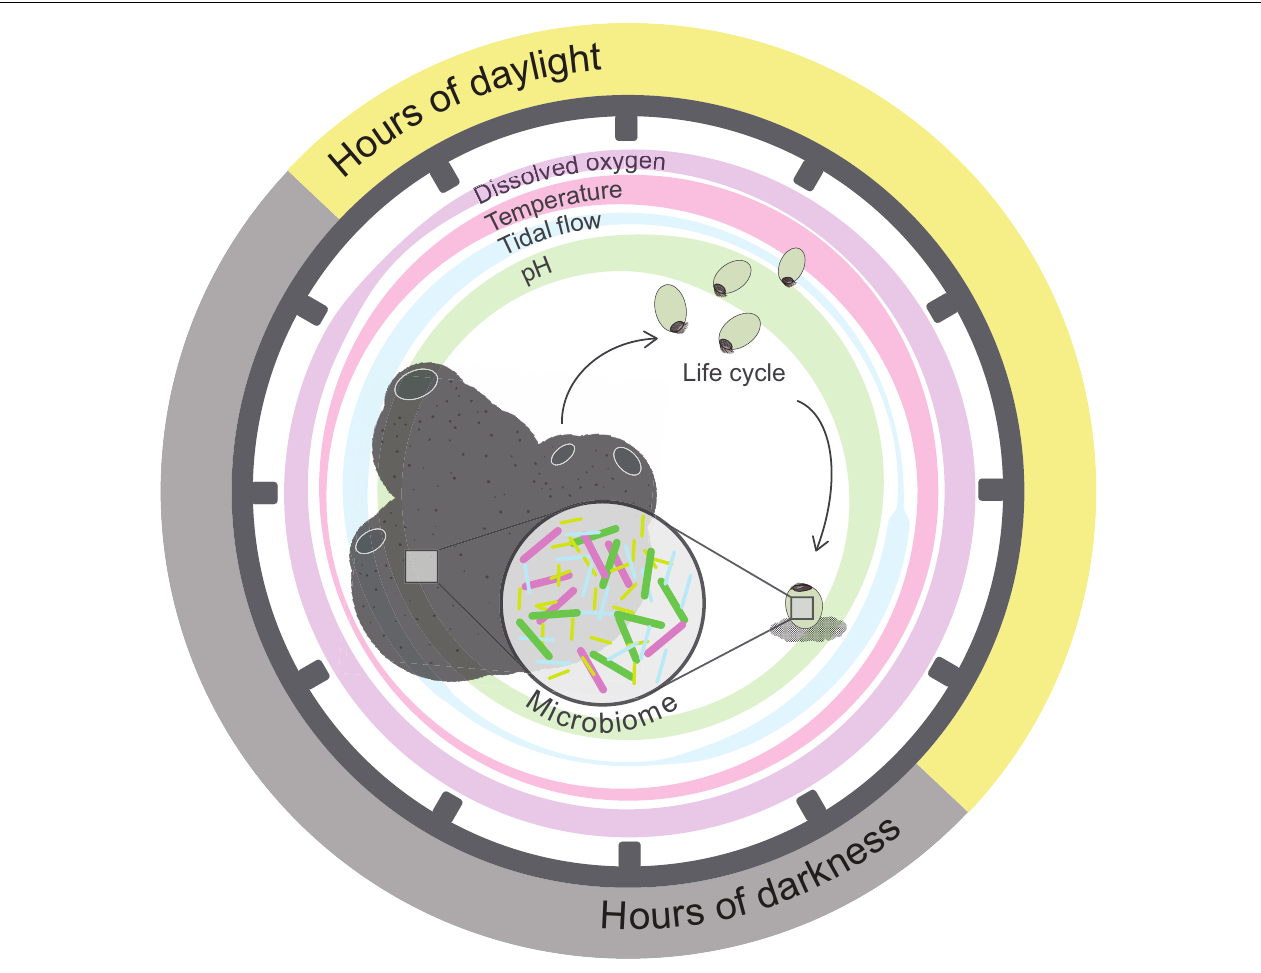
FIGURE 2 | Representation of daily fluctuating environmental factors that may entrain rhythms within a shallow-water marine sponge holobiont. Representation of typical daily fluctuating environmental variables/abiotic parameters within a shallow-water marine habitat (i.e., zeitgebers) that can entrain rhythms for sessile organisms, such as a sponge (shown here). Parameters depicted here by colored circles are hours of daylight, dissolved oxygen, water temperature, tide level, pH, that vary systematically throughout a diel cycle, as indicated here by circle width. The relative influence of independent environmental parameters over an organism’s rhythms will likely vary for the host compared with its microbial symbionts, with symbionts often effected more so. Additionally, each environmental variable may independently entrain diverse rhythms with periods such as circadian, diurnal, ultradian, or circatidal. Successful rhythmic regulation is critical for sponge holobiont development during each stage of its pelago-benthic life cycle. Within the coral reef sponge, A. queenslandica timing of larval release into the water column, development of competency, and larval descent to the sea floor before settlement onto the substrate occurs regularly at the same time each day, in alignment with key environmental cues (Degnan and Degnan, 2010; Jindrich et al., 2017). Importantly, at each life cycle stage this sponge houses vertically and/or horizontally acquired symbionts (Ereskovsky et al., 2005; Maldonado, 2007; Schmitt et al., 2008; Fieth et al., 2016), for which rhythmic regulation must be considered. Dark gray tick marks on circle represent time throughout a 24-h